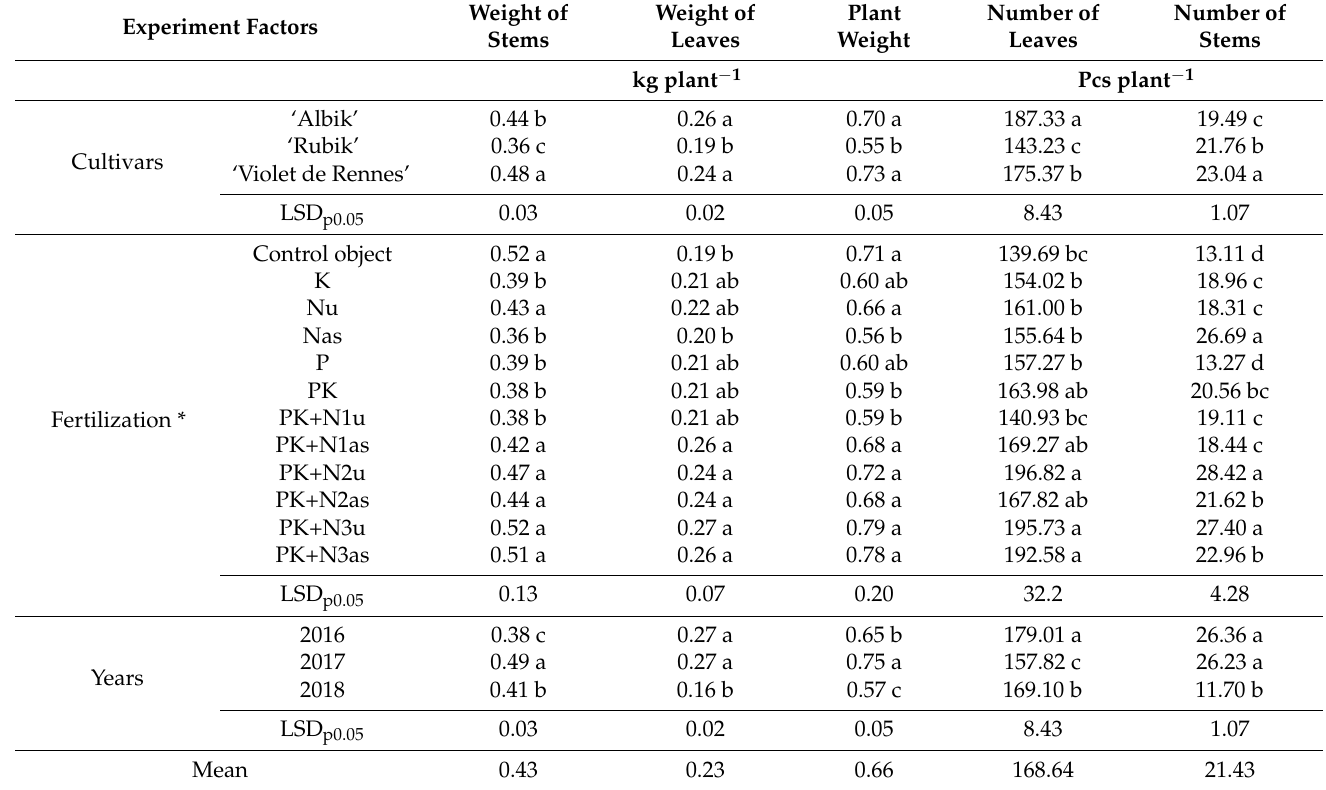
Table 7. Structure of weights and numbers of the aboveground parts of